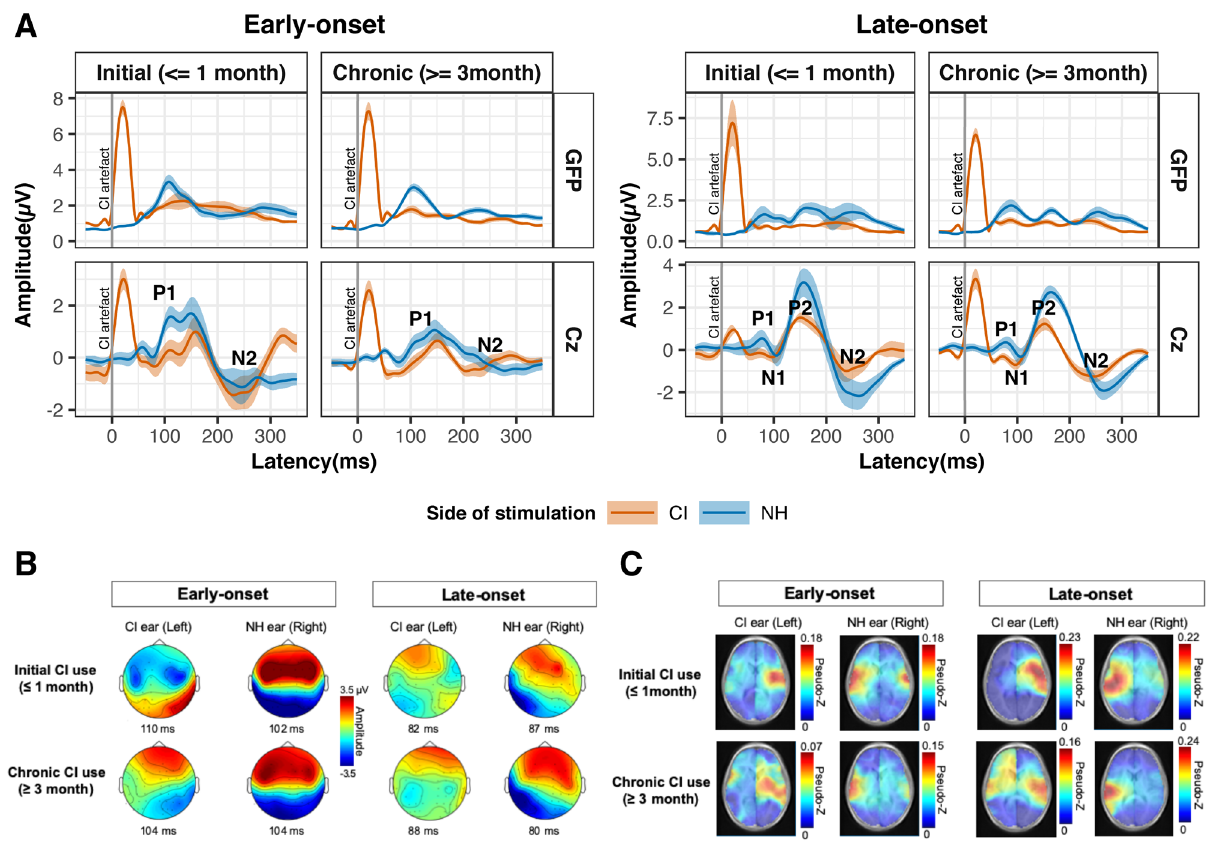
Figure 1. Auditory-evoked surface and source cortical activity. (A) The global field power (GFP; spatial standard deviation of surface potentials across electrodes) and cortical response at Cz electrode were averaged per group at two stages of initial cochlear implant (CI) use (0–1 month, early-onset: 15 responses in 11 children; late-onset: 6 responses in 6 children) and chronic CI use (≥ 3 month, early-onset: 27 responses in 15 children; late-onset: 14 responses in 6 children). Mean (solid line) ± standard error (shaded region) amplitude was plotted as a function of post-stimulus time for each stimulation mode. (B) Topographic distribution of mean average- referenced EEG activity across the surface of the head at the peak latency. (C) Axial view of mean evoked source activity (post-omnibus pseudo-Z) in ~ 64 k voxels that were evaluated using the TRACS beamformer shows the highest activation in the auditory cortex contralateral to the stimulated ear (normal hearing (NH) or cochlear implant (CI)). Note: The images in (B) and (C) were generated by flipping the x-axis in right CI users before averaging for